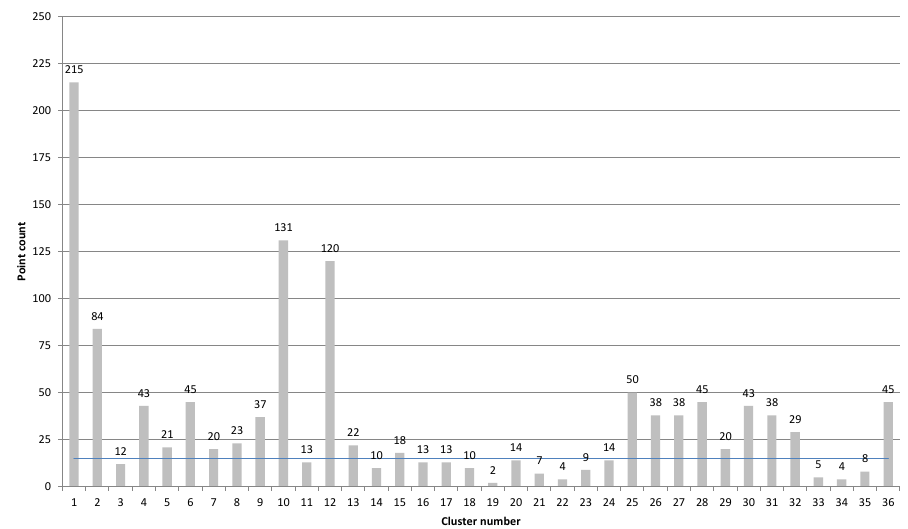
Fig. 6. GNIP station data points per climatic cluster. The blue line indicates the minimum number of data points (15) to successfully derive a M4 best-fit regression model for a given